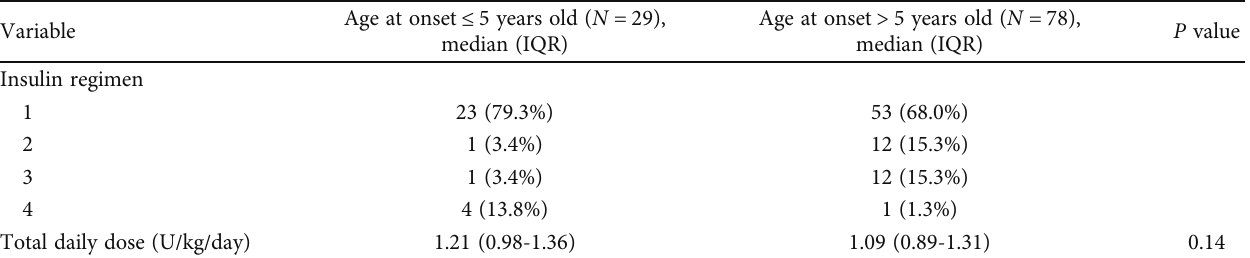
Table 2: Medication usage between di ff erent groups of age at onset in patients with T1D.